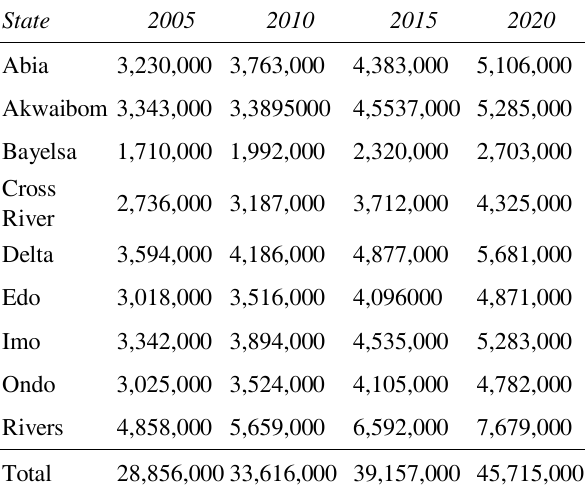
Table 1: Population Projections High for the Niger